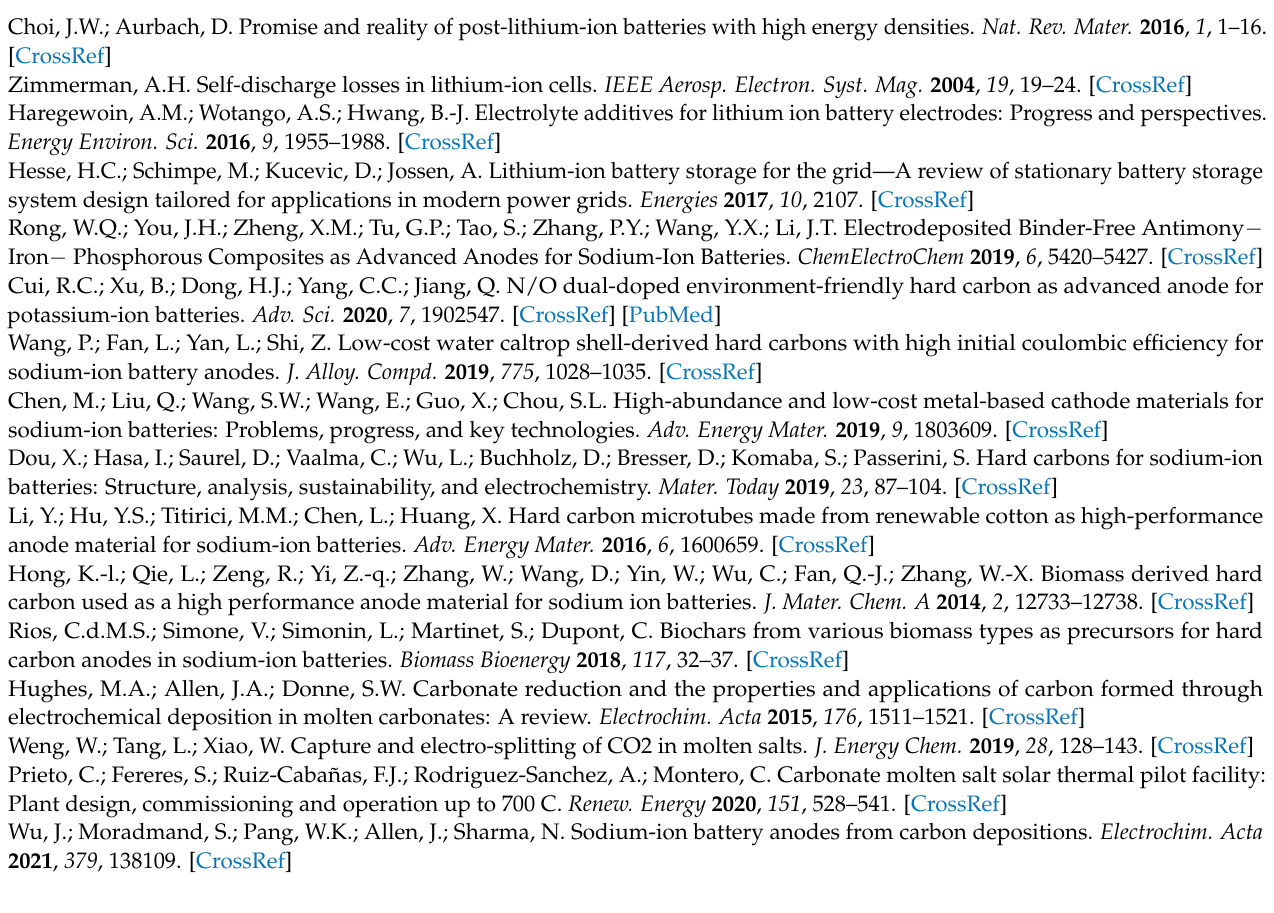
Figure S5: Raman spectra and optical images; Figure S6: Voltage versus capacity curves for Cu-600 and Au-600; Figure S7: Voltage versus capacity curves for the G samples; Figure S8: Summary of short term electrochemical performance; Figure S9: Electrochemical performance against K/K + ; Figure S10: Long term cycling data; Figure S11: Summary of capacity retention in K/K +